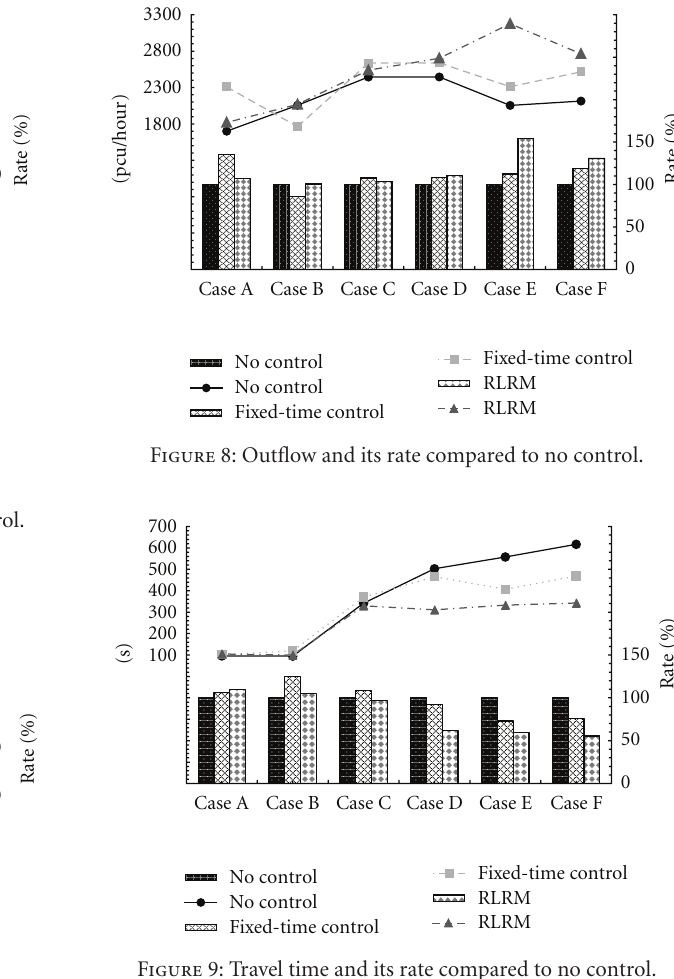
Figure 9: Travel time and its rate compared to no